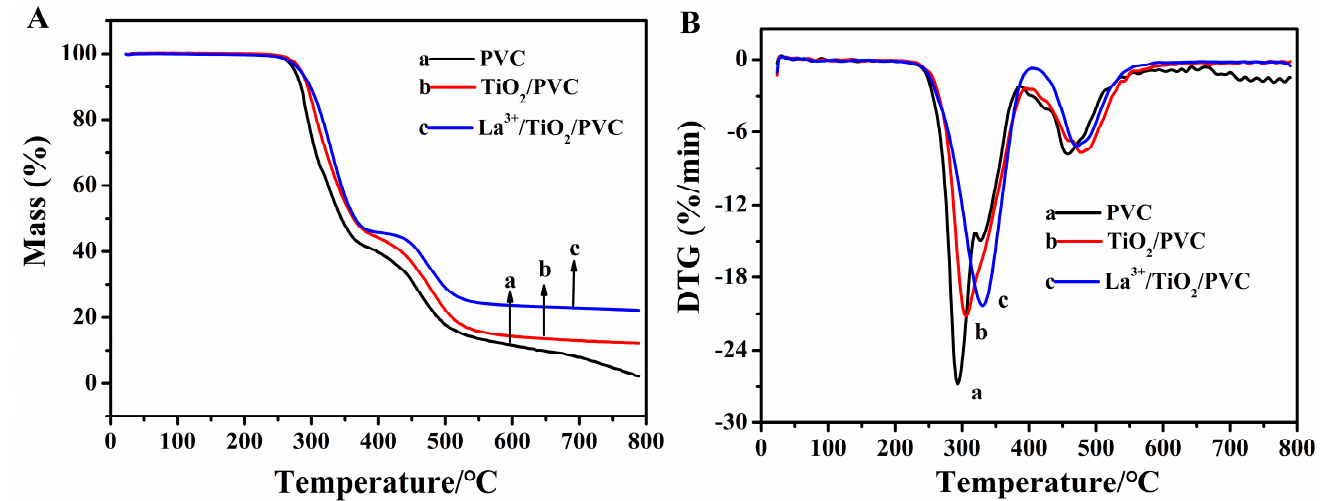
Figure 9. ( A ) TG and ( B ) DTG curves of three kinds of films.